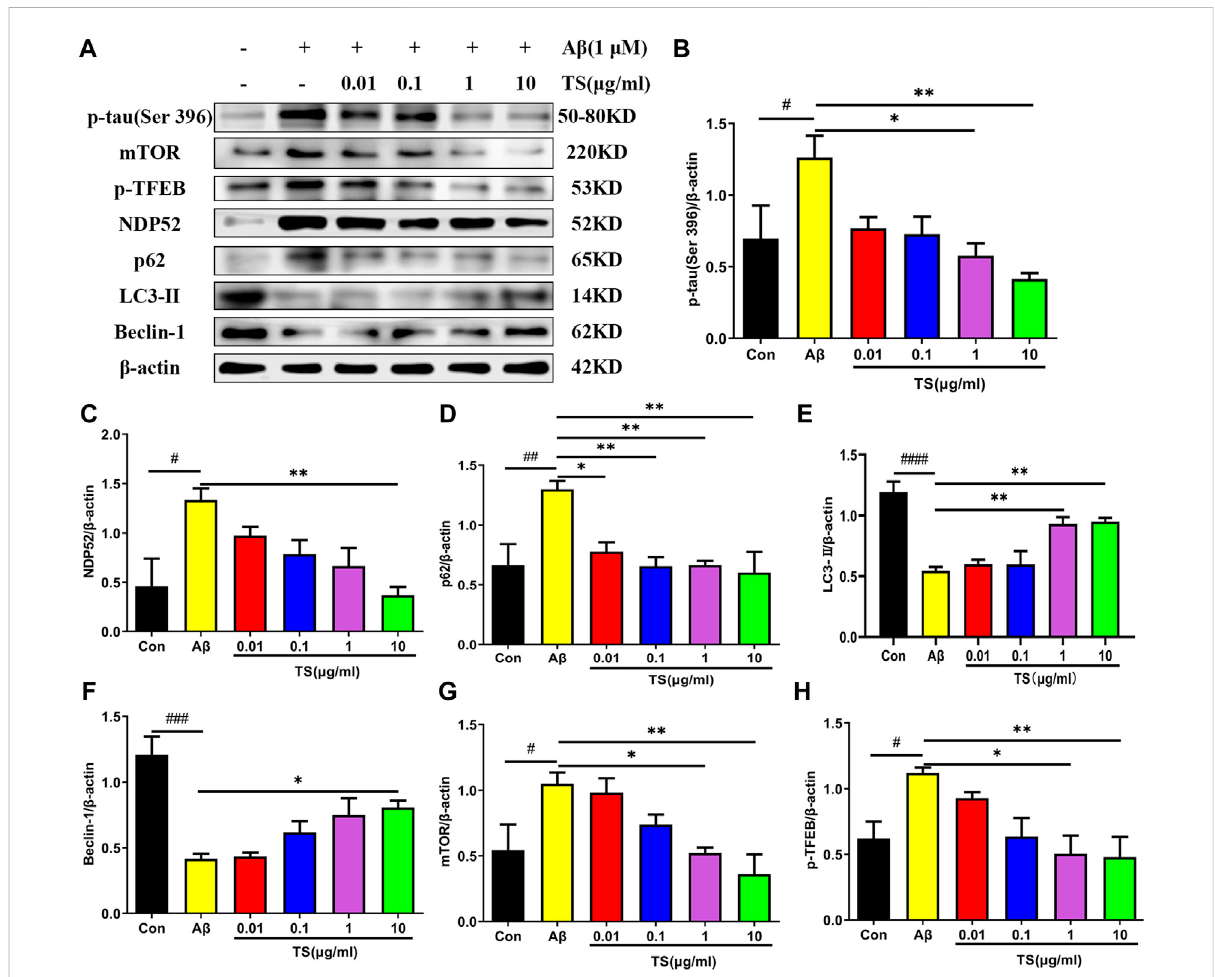
FIGURE 6 TS treatment promoted autophagy and clear p- tau. (A) The effect of TS on p- tau (Ser 396), NDP52, p62 and LC3-II and Beclin-1 proteins in the A β -induced PC12 cells were detected by Western blot. (B) Quantitative analysis of the relative expression concertation of p- tau (Ser 396) protein in eachgroup( # p =0.0409,* p =0.0130,** p =0.0029). (C) QuantitativeanalysisoftherelativeexpressionconcertationofNDP52proteinineachgroup ( # p = 0.0113, ** p = 0.0057). (D) Quantitative analysis of the gray value of p62 protein bands in each group ( ## p = 0.0093, * p = 0.0312, ** p = 0.0084,** p =0.0093,** p =0.0047). (E) QuantitativeanalysisoftherelativeexpressionconcertationofLC3-IIproteinineachgroup( #### p < 0.0001, ** p = 0.0053, ** p = 0.0037). (F) Quantitative analysis of the relative expression concertation of Beclin-1 protein in each group ( ### p = 0.0002, * p = 0.0356). (G) Quantitative analysis of the relative expression level of mTOR protein in each group ( # p = 0.0450, * p = 0.0359, ** p = 0.0068). (H) Quantitative analysis of the relative expression level of p- TFEB protein in each group ( # p = 0.0435, * p = 0.0129, ** p = 0.0099). # Compared with WT group; *Compared with model group. Data are presented as mean ± SEM ( n =